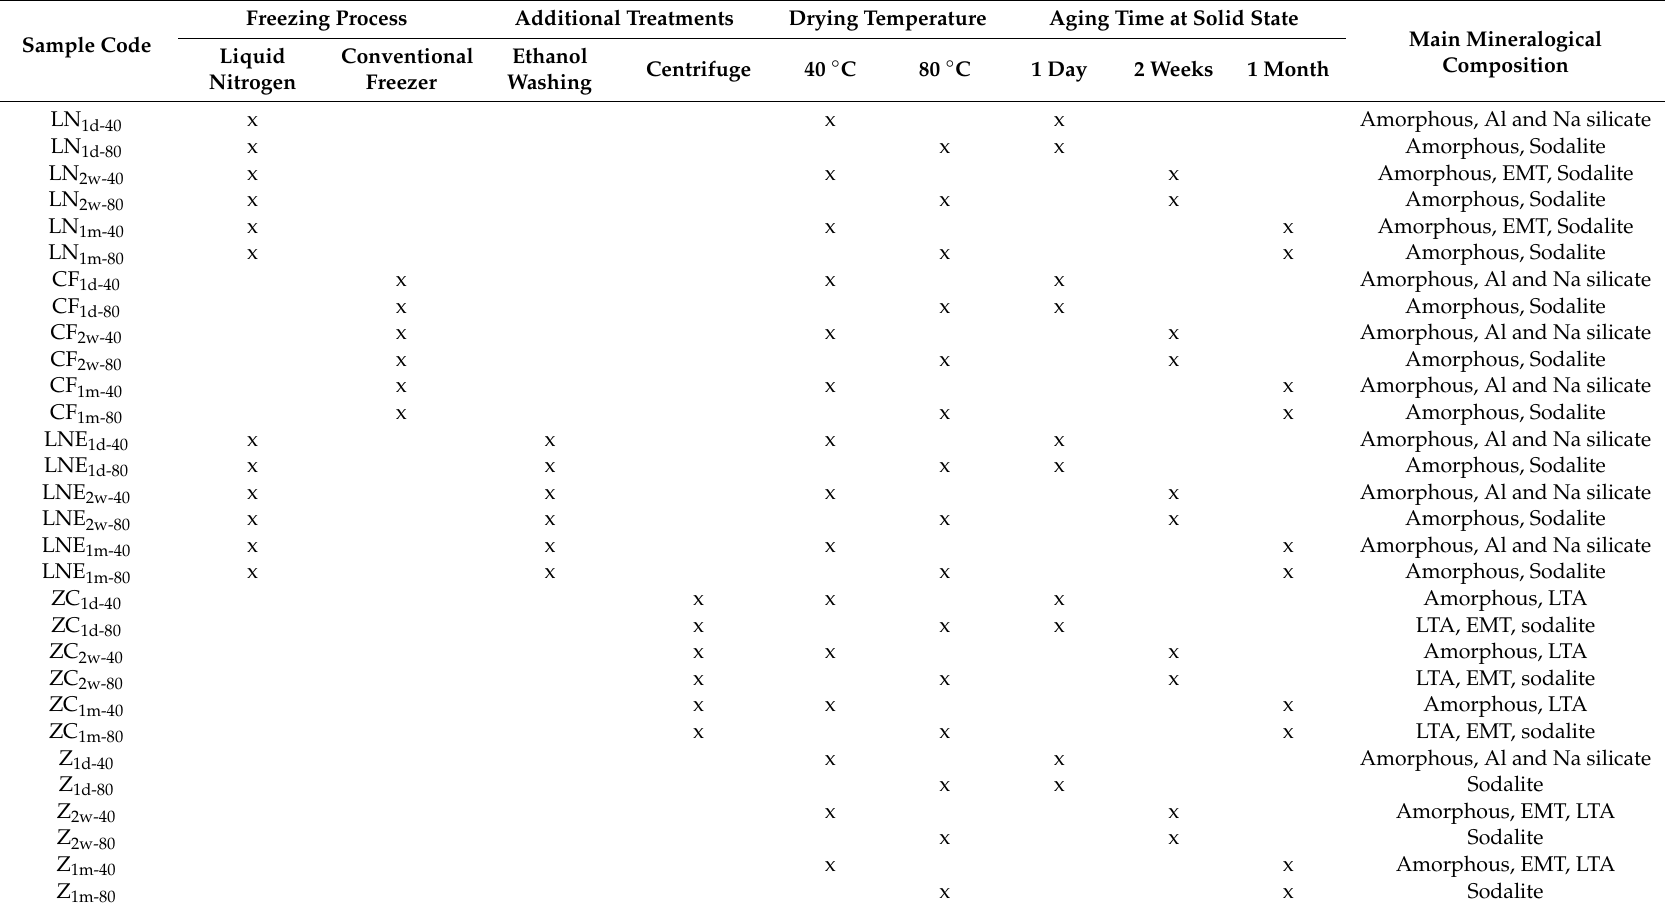
Table 1. Scheme of Experiemnts and Relative Sample